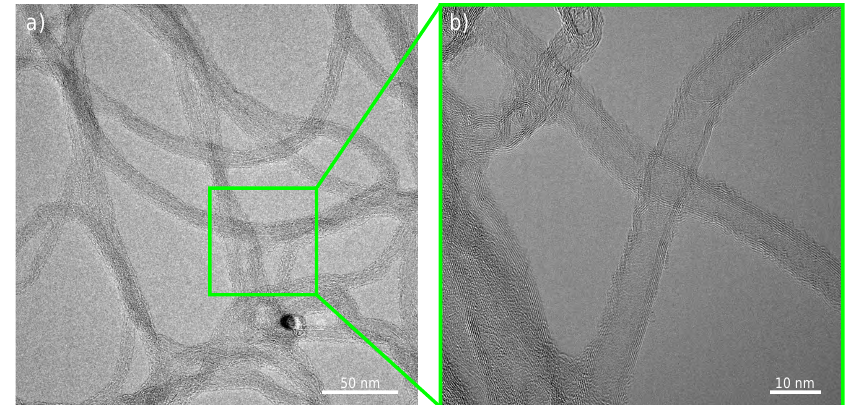
Figure A13. TEM images for CNTB at ( a ) low magnification and ( b ) high magnification.